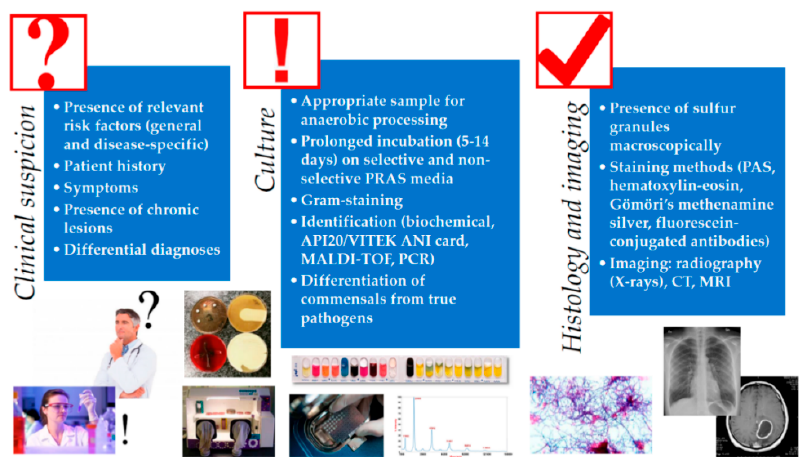
Figure 3. Diagnostic algorithm for the diagnosis of Actinomyces infections (reproduced with permission from [1]). Abbreviations: PRAS: pre-reduced, anaerobically sterilized; MALDI-TOF: